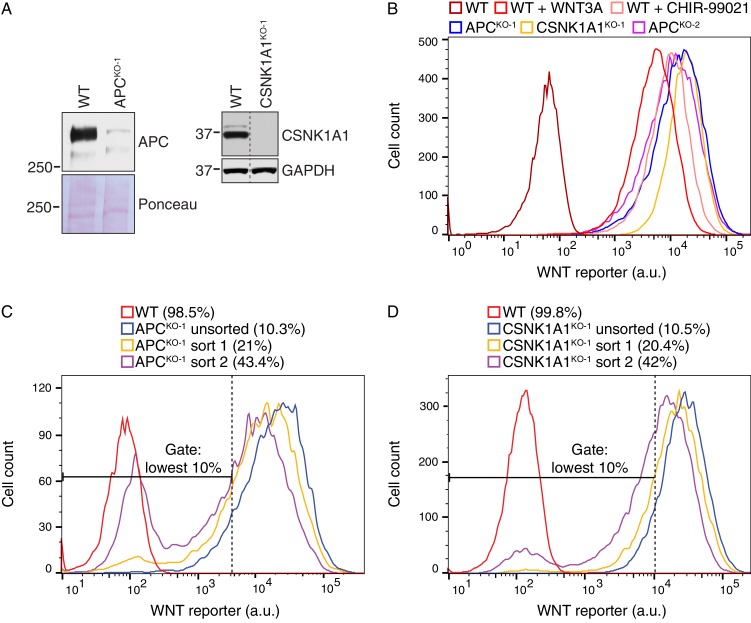
Suppressor screens in cells lacking APC or CSNK1A1 reveal genotype-specific signaling requirements.(A) Immunoblot analysis of the APCKO-1 (left blots) and CSNK1A1KO-1 (right blots) cell lines used for suppressor screens. For the APC blot, Ponceau S staining was used to assess loading. For the CSNK1A1 blot, the appropriate lanes from the CSNK1A1 blot shown in Figure 6H and the corresponding GAPDH loading controls (not pictured in Figure 6H) were cropped and juxtaposed. (B) Histogram depicting WNT reporter activity for ~22,500 WT HAP1-7TGP, APCKO-1, CSNK1A1KO-1 and APCKO-2 cells. Where indicated, WT cells were treated with 50% WNT3A CM or 10 μM of the GSK3 antagonist CHIR-99021. (C–D) Histograms depicting WNT reporter activity from ~9500 mutagenized APCKO-1 cells (C) or ~20,000 mutagenized CSNK1A1KO-1 cells (D) enriched during the APC and CSNK1A1 suppressor screens, respectively (Figure 5B and C). Unsorted cells and cells amplified following sort 1 or sort 2 using the indicated lowest 10% EGFP fluorescence gate are depicted, and the percentage of cells within this gate for each population is indicated in parenthesis. WT HAP1-7TGP cells are shown for reference.